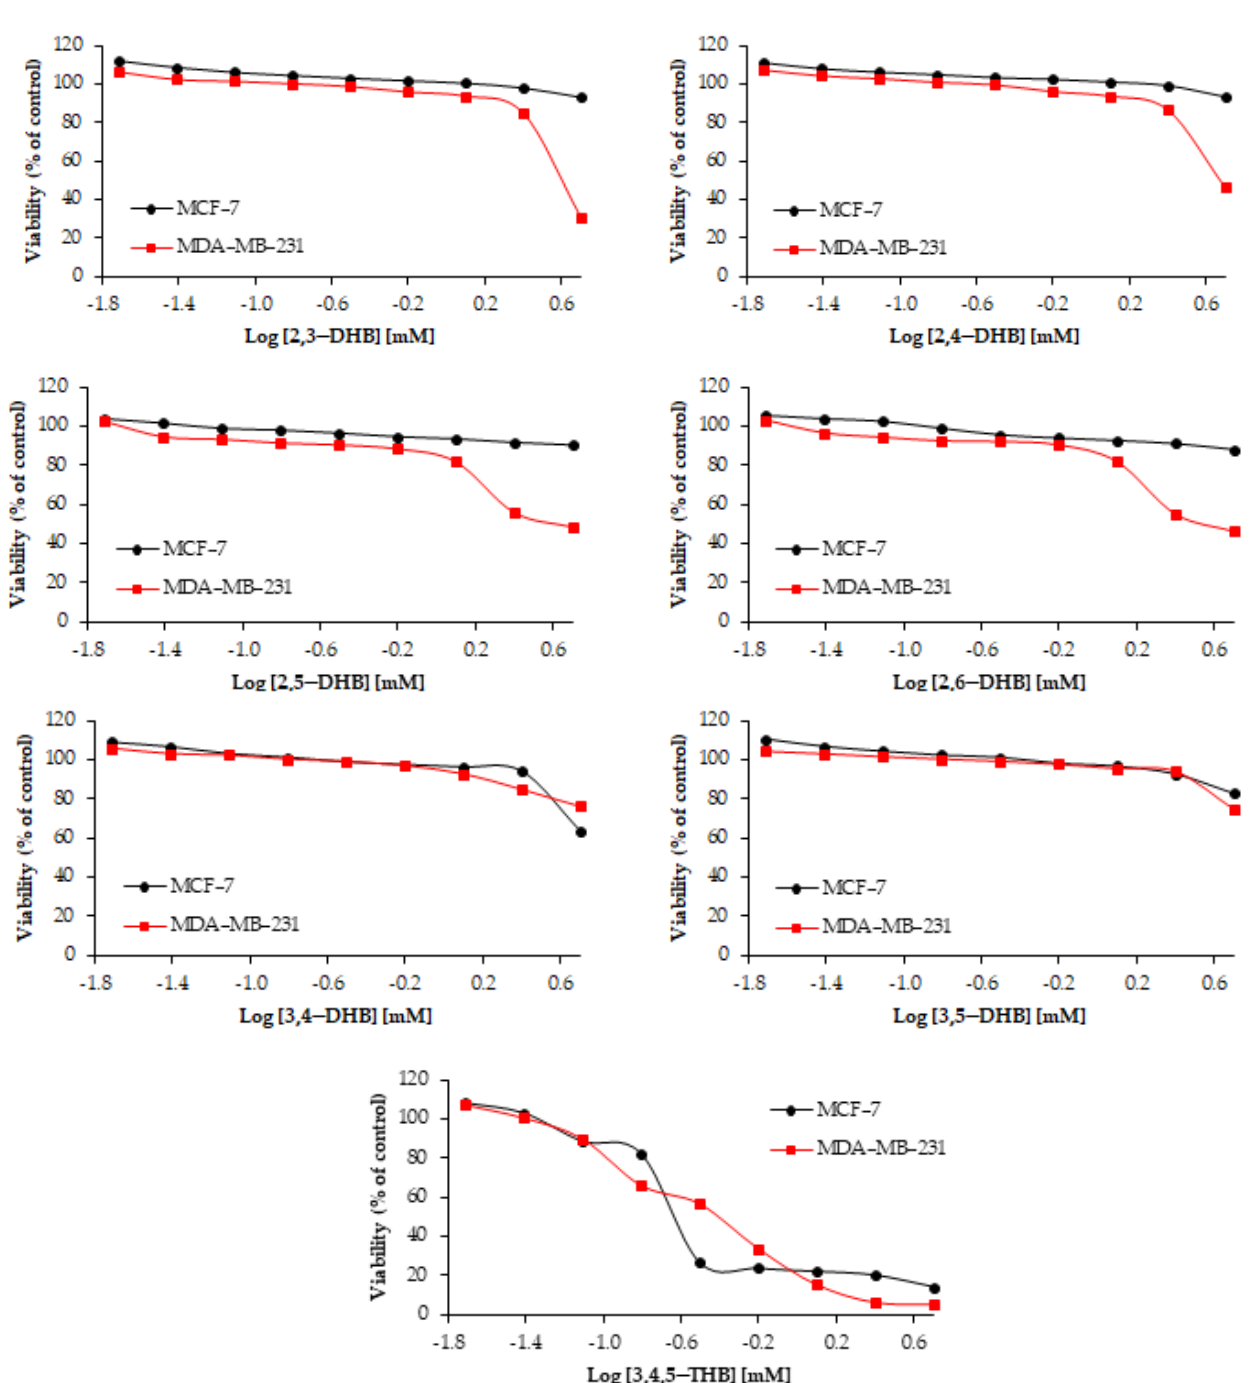
Figure 6. Survival curves of MDA-MB-231 and MCF-7 cells in the presence of different concentrations of the tested hydroxybenzoic acids.